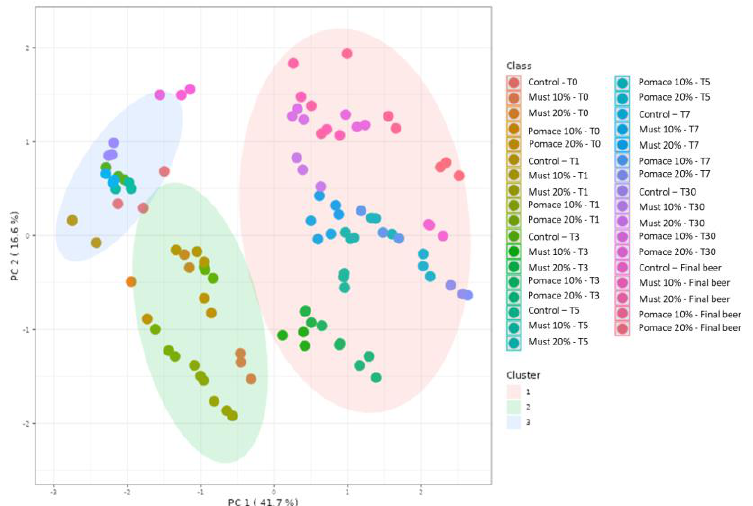
Figure 3. PCA score plot resulting from the unsupervised k-means clustering of the different (poly)phenols under investigation in the sub-samples collected during fermentation in the IGA and control beers, revealing three major groups according to the log-transformed (poly)phenol concen- tration.